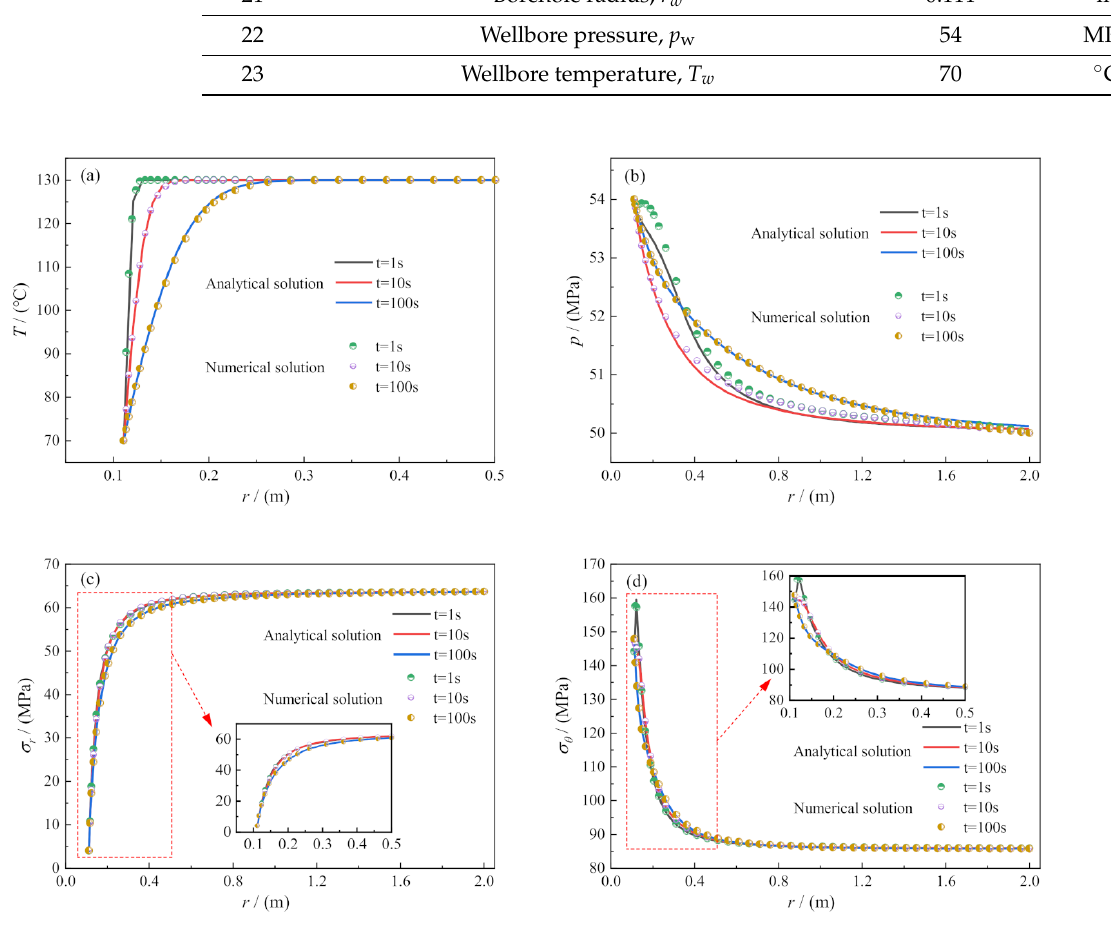
Figure 3. Radial distributions of the temperature, pressure, and stress after drilling. ( a ) Temperature; ( b ) Pore pressure; ( c ) Radial stress; ( d ) Circumferential